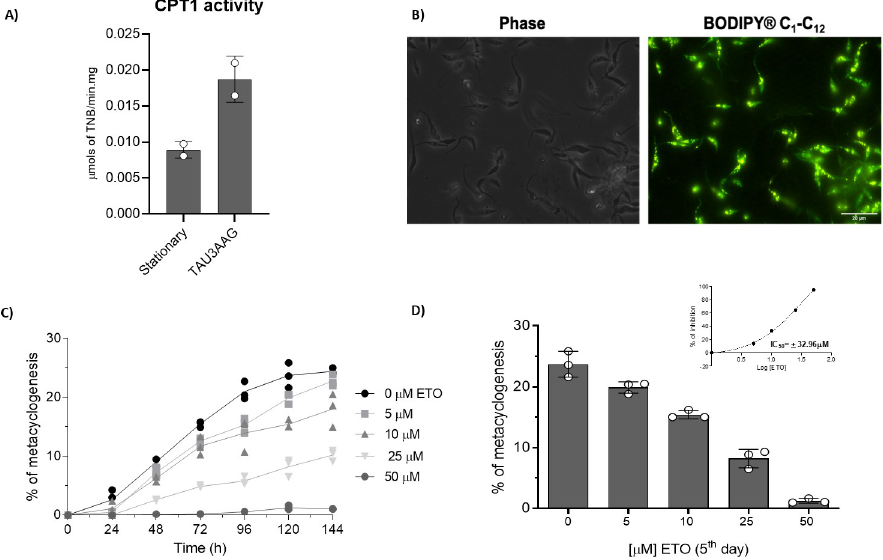
Fig 12. ETO inhibits metacyclogenesis. A) CPT1 activity of epimastigote forms in stationary phase and 24h after incubated in TAU-3AAG medium (for triggering metacyclogenesis). B) Fluorescence microscopy of cells incubated in TAU-3AAG in the presence of BODIPY 500–510 C 1 -C 12 . C) Effects of different ETO concentrations on metacyclogenesis. The differentiation was evaluated by counting the cells in a Neubauer chamber each day for 6